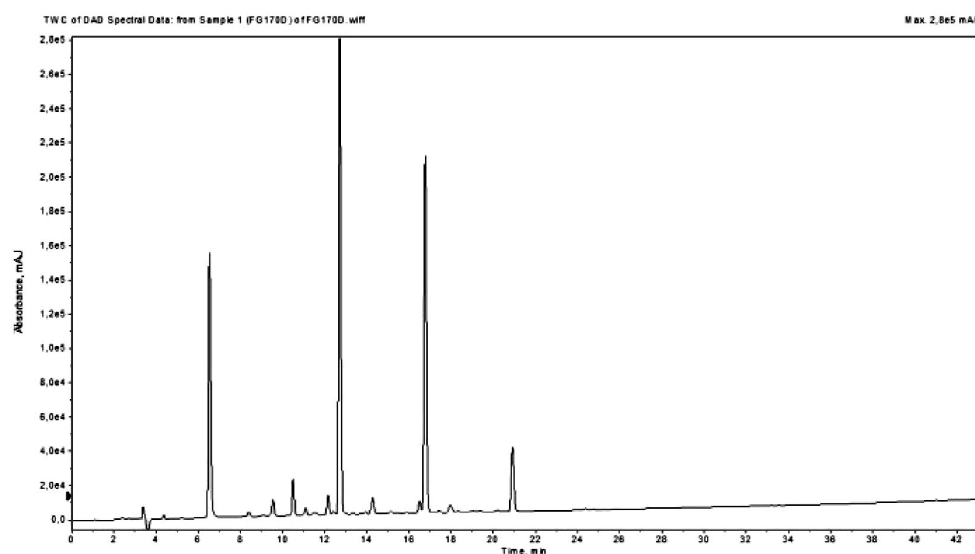
Figure 2. LC-MS/MS chromatogram of ethyl acetate extract of S. subnuda Table 1. Characterization of phenolic compounds in the ethyl acetate extract of S. subnuda No Rt